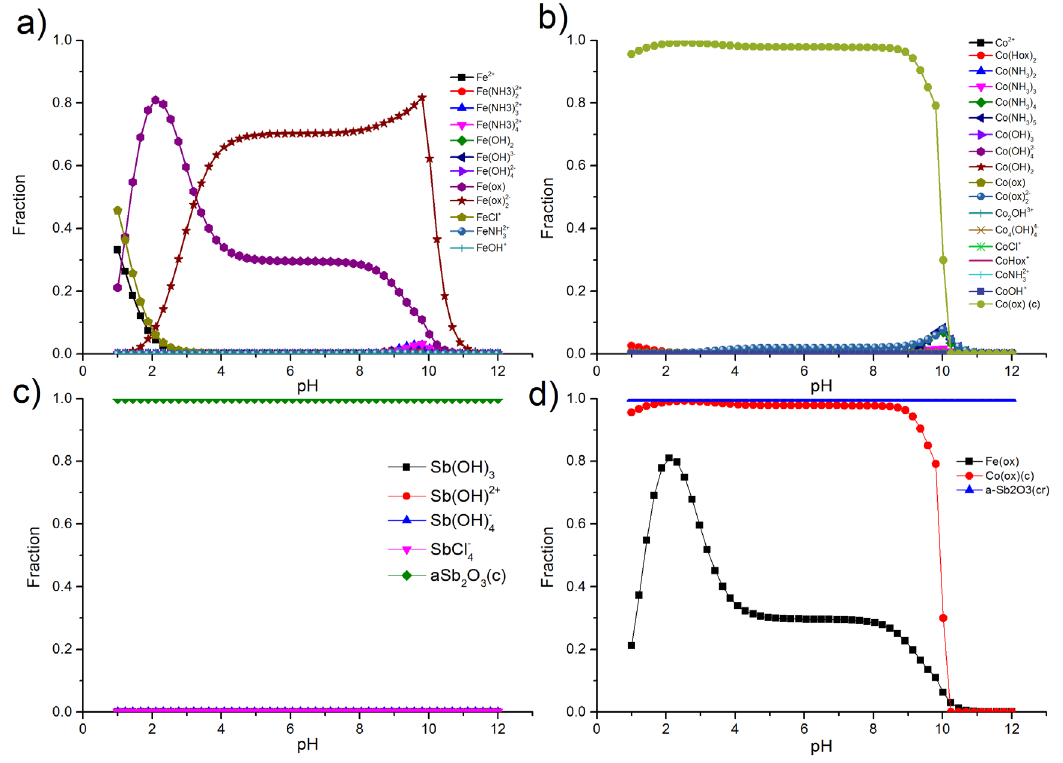
Figure 1: Thermodynamic modeling showing the speciation of a) Fe 2+ b) Co 2+ , c) Sb 3+ species and d) overlay of desired